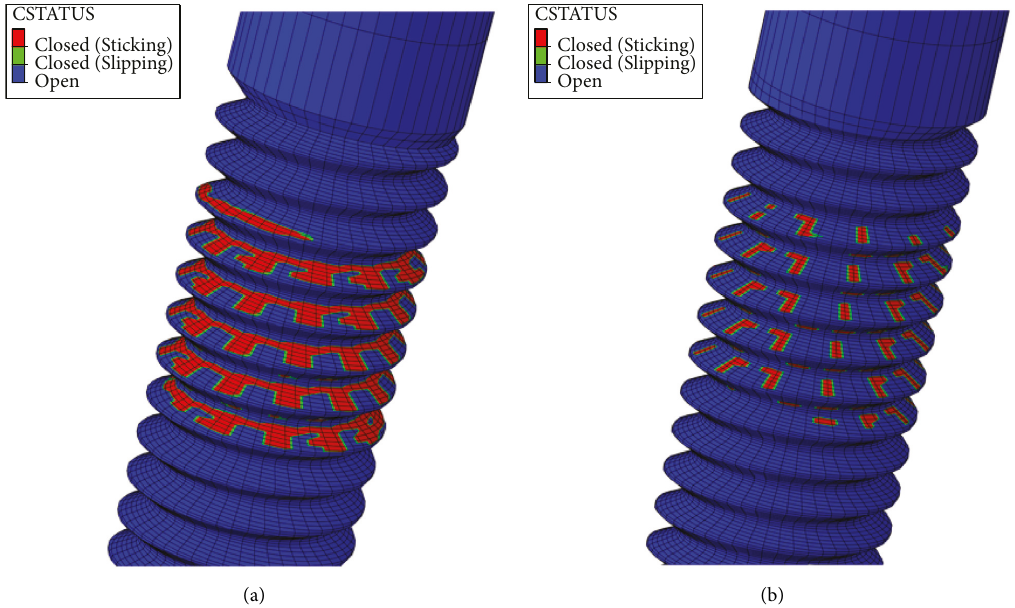
Figure 17: Thread contact state (six bolts’ flange structure under 1.5kN impact load on the top). (a) No loosening with 5000N bolt preload. (b) Loosening to 300N bolt preload.